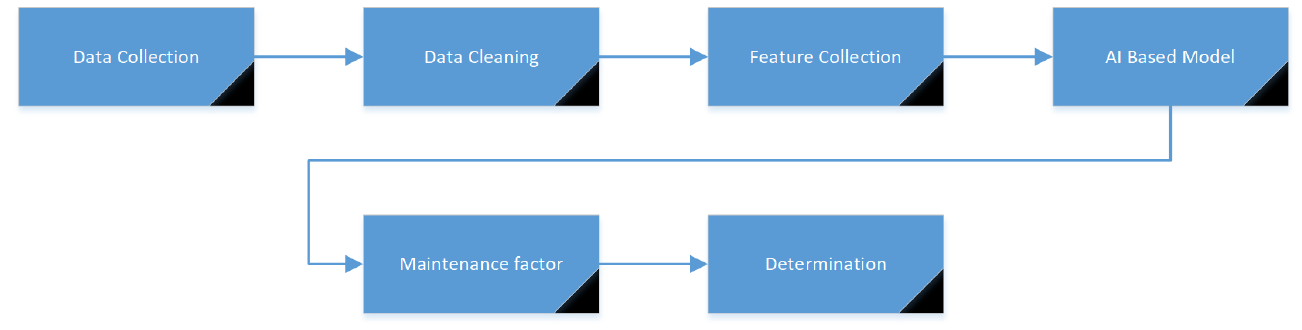
Figure 4. Block diagram of the proposed methodology.